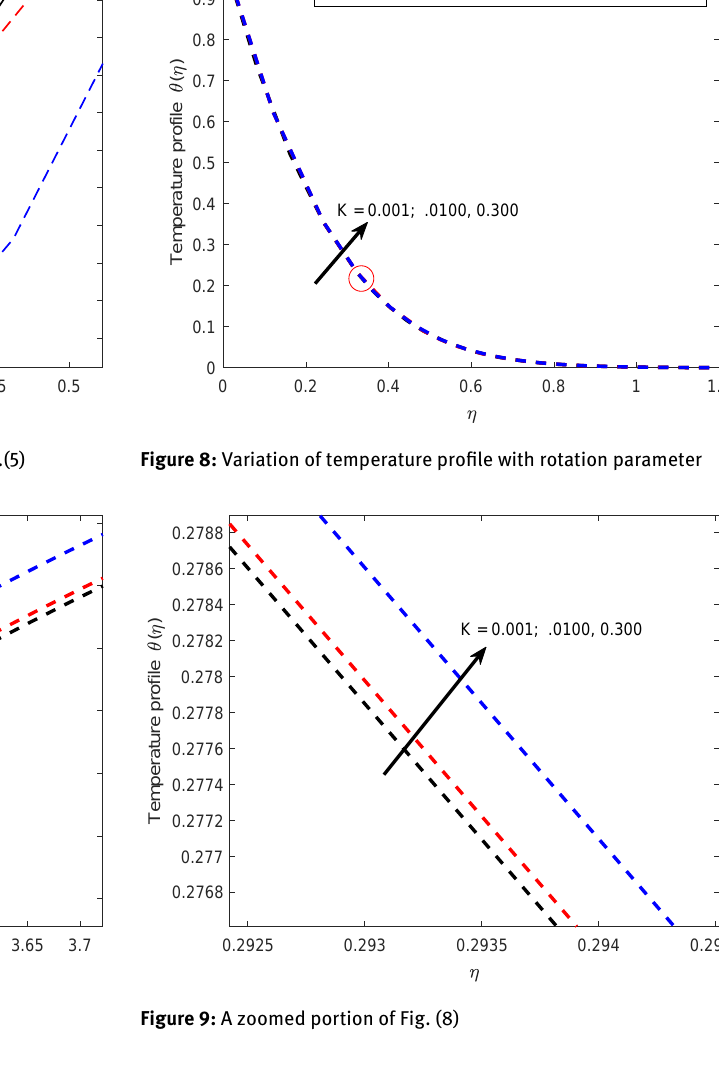
leads to a slight increase in the temperature profile. As fur- ther shown in Fig. (15), a simultaneous increase in both the Casson fluid parameter and rotation parameter leads to an increase in the temperature profiles.